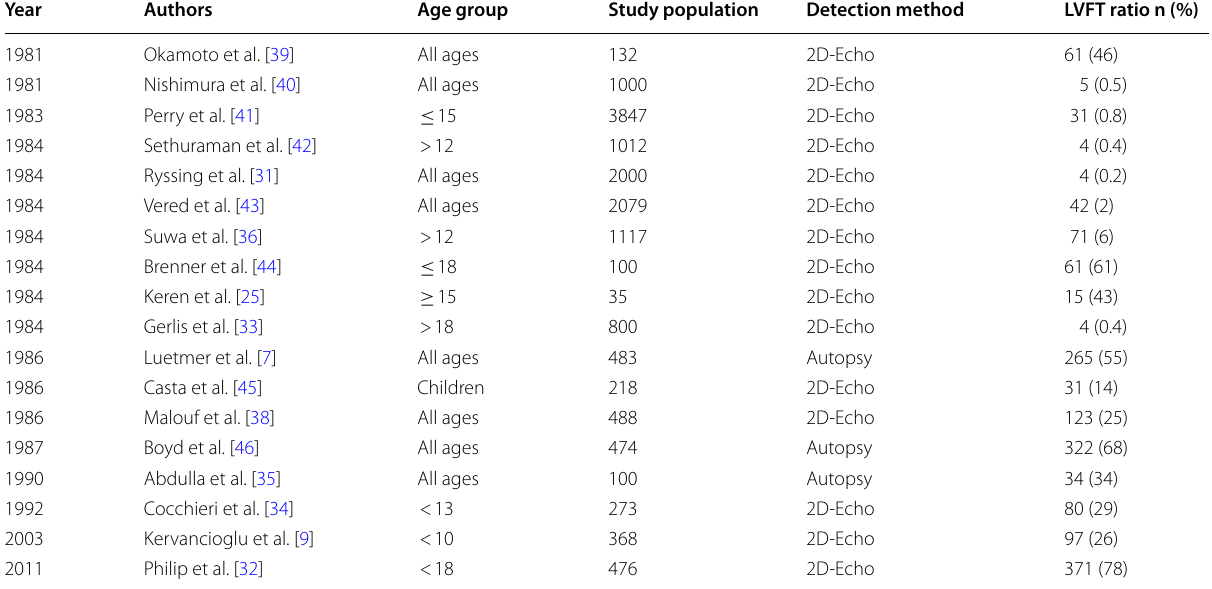
2 D-Echo Two-dimensional transthoracic echocardiography; LVFT Left ventricular false tendon